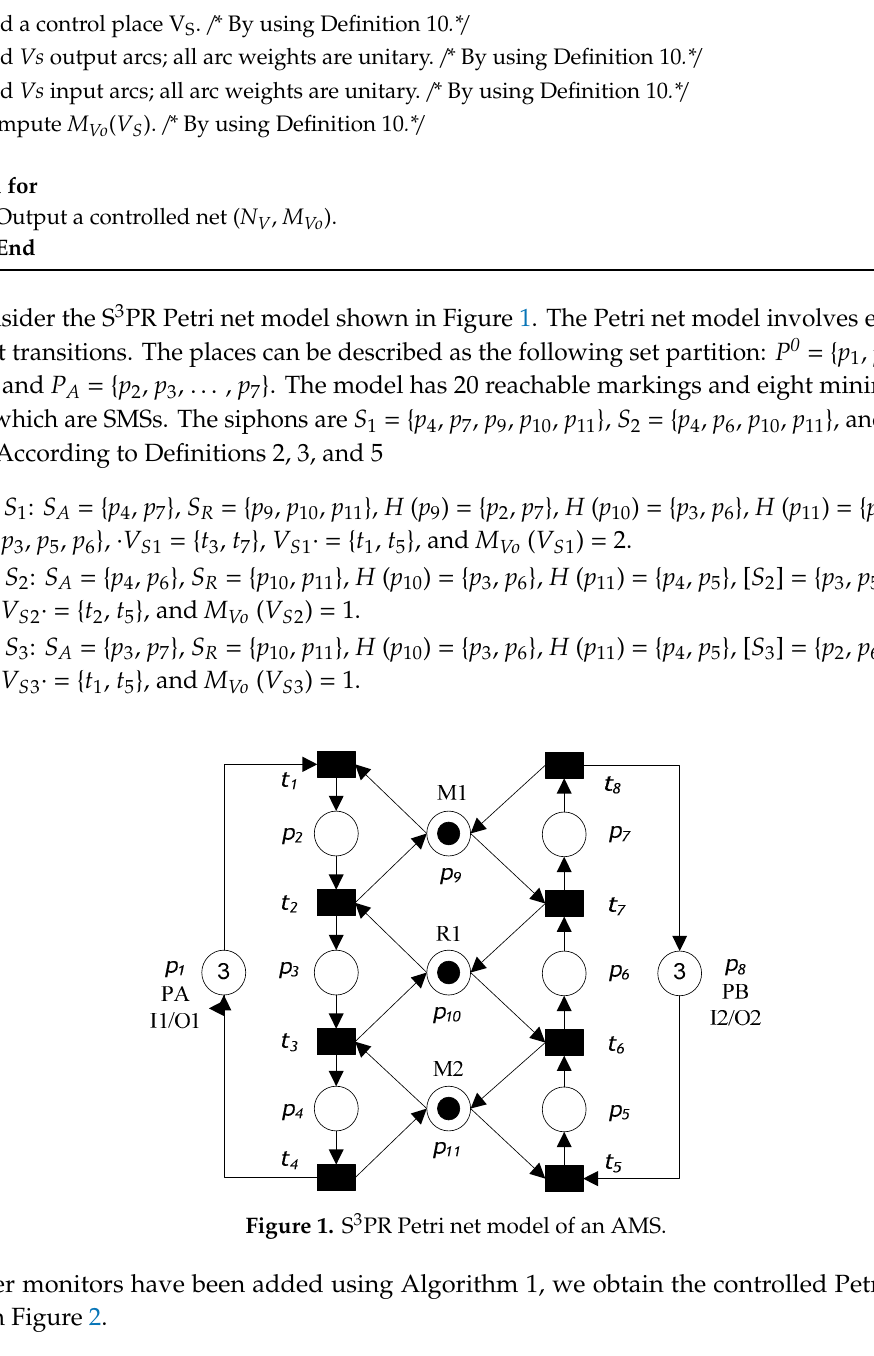
Figure 2. Controlled S 3 PR Petri net model. Definition 11. Let (N, M o ) be an S 3 PR with N = (P A ∪ {p 0 } ∪ P R , T, F, M o ). The deadlock controller for (N, M o ) developed in Ezpeleta et al. [1] is denoted as (V, M Vo ) = (P V , T V , F V , M Vo ). Here, (V, M Vo ) can be reduced and replaced by a colored common deadlock control subnet, which is a PN N DC = ({p combined }, {T DCi ∪ T DCo }, F DC , C vsi ), where p combined is called the merged control place of all monitors P V = {V S \ S ∈ 𝛱 }. T DCi = {t \ t ∈ • V S }. T DCo